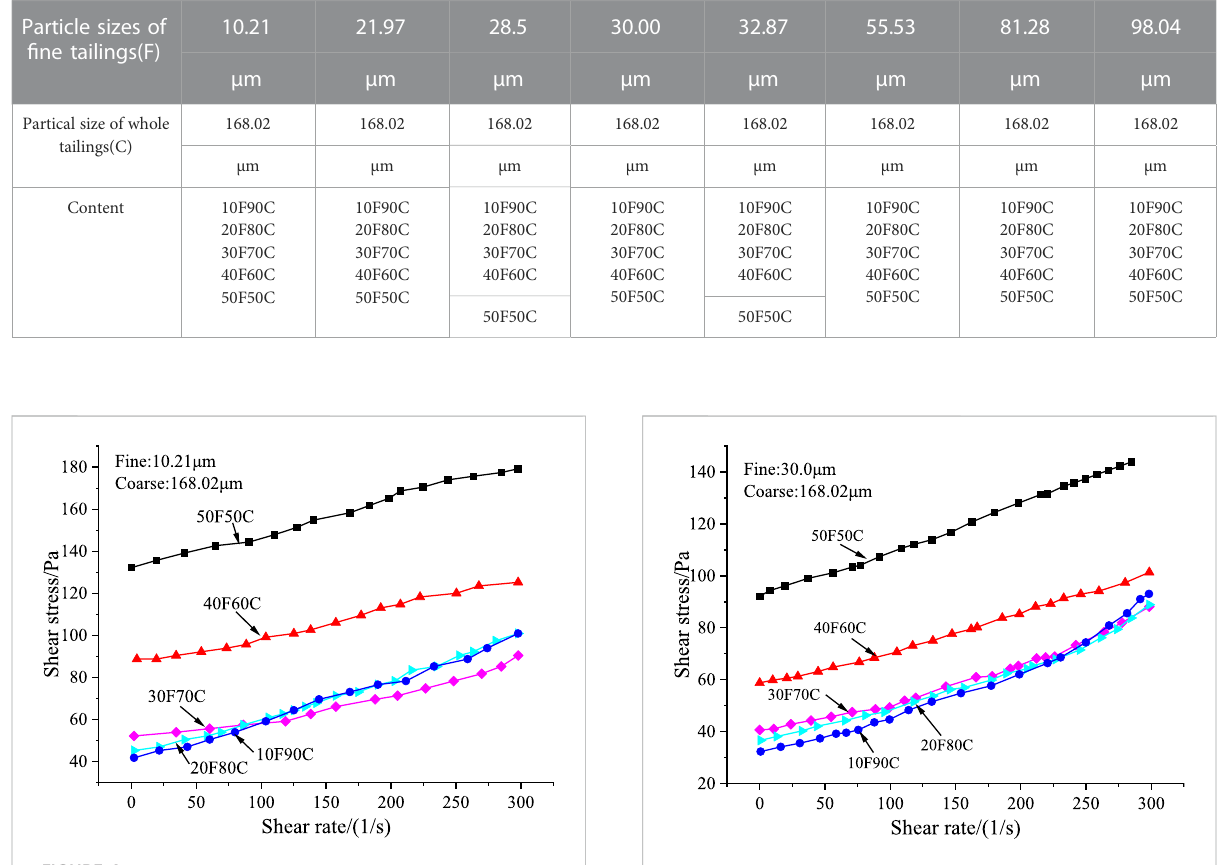
FIGURE 6 The shear stress-hear rate rheological curve of particle diameter 28.5 μ